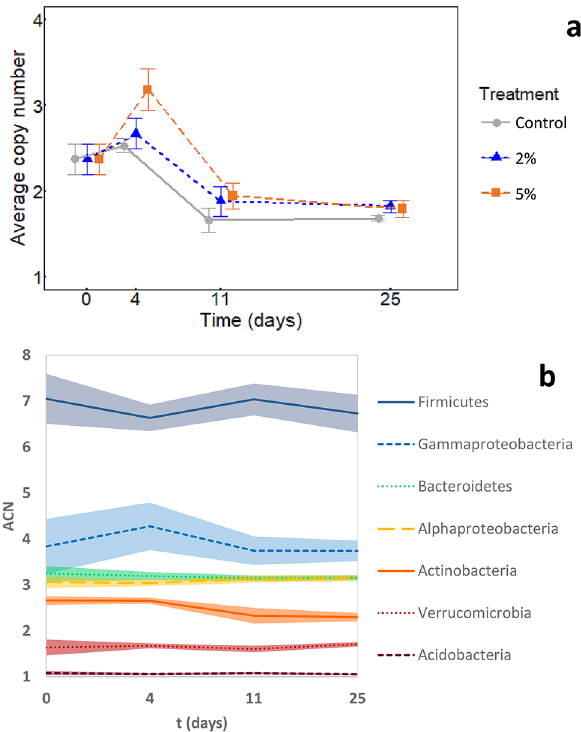
Figure 5. ( A ) r and K strategists in microbial community according to average 16rRNA copy number per genome (ACN) in control and samples amended by artificial exudates in concentration of 2% and 5% of total DOC during 25 days incubation. ( B ) Changes in each particular bacterial phylum in samples amended by artificial exudates in concentration of 2% of total DOC during 25 days incubation and ( C ) in concentration of 5% of total DOC during 25 days incubation. Enhanced ACN in the prokaryotic community indicates increased abundance of r-strategic species (means, ± standard deviations, n =